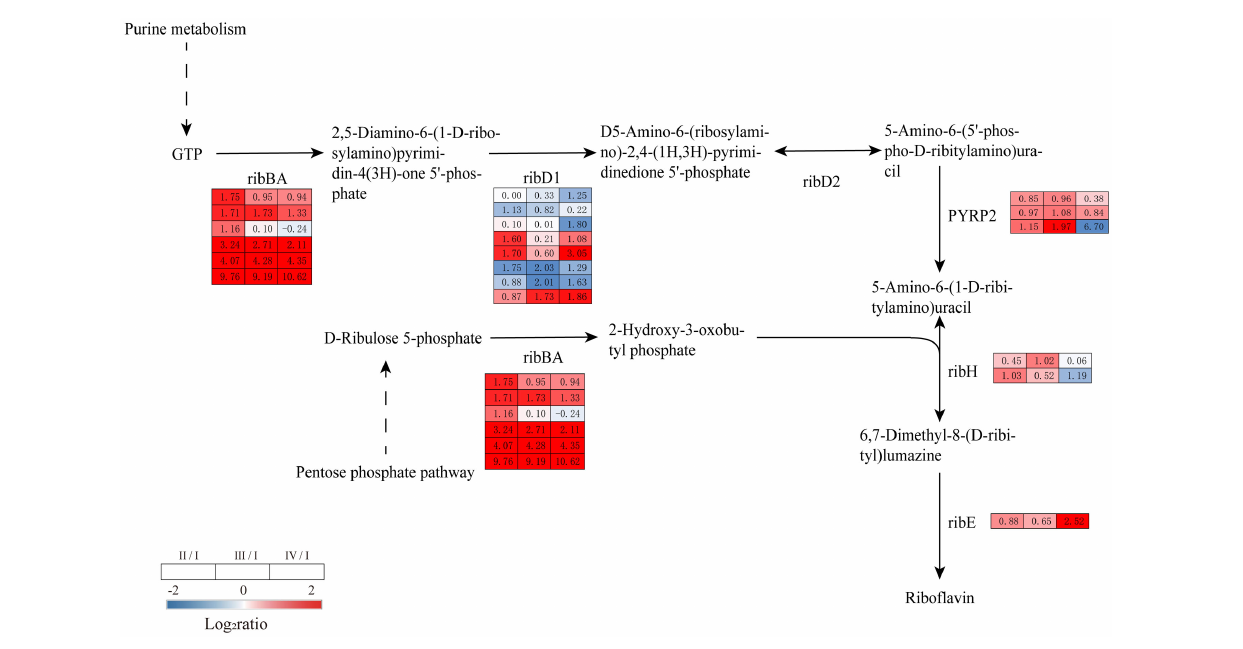
FIGURE 9 The transcriptomic changes with ribo fl avin metabolism in the tetraspore formation of G. lemaneiformis between different phases. Red and blue gradients indicate the upregulation and downregulation of unigenes with the adjusted p value<0.001 and |log2ratio|>1, separately, while white represent no signi fi cant difference.